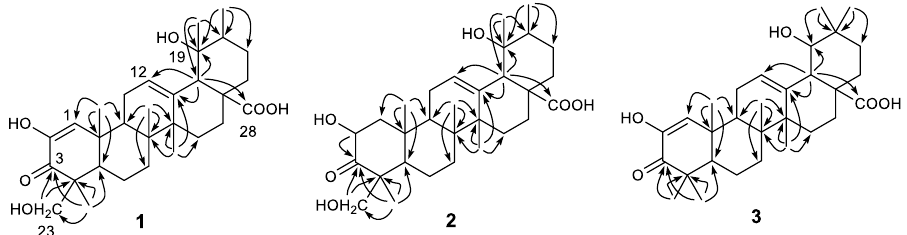
Figure 2. Observed key HMBC correlations of triterpenoids 1 − 3 .